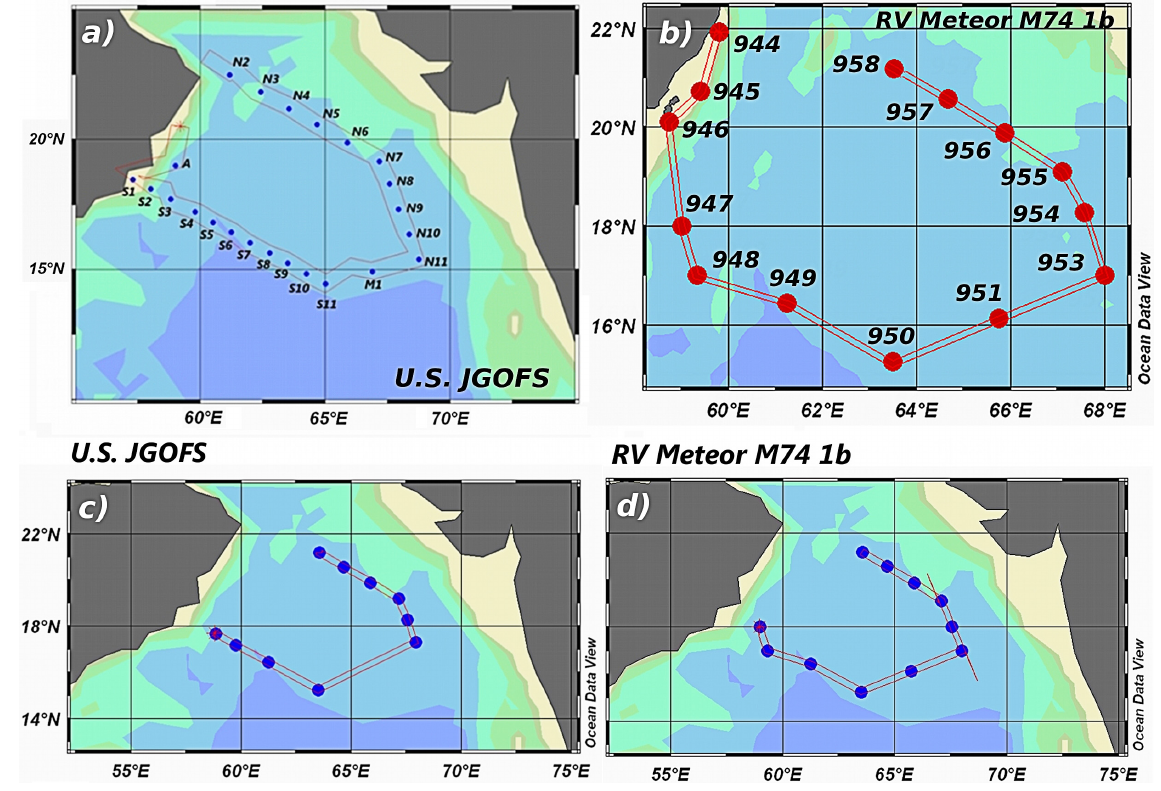
Figure 3. Cruise tracks and stations of the US JGOFS cruises in 1995 (a) and the RV Meteor cruise M74/1b in 2007 (b) , as well as the transects used to produce the cross sections in Fig. 4 (a) , Fig. 5 (b) , and Fig. 6 (c, d)